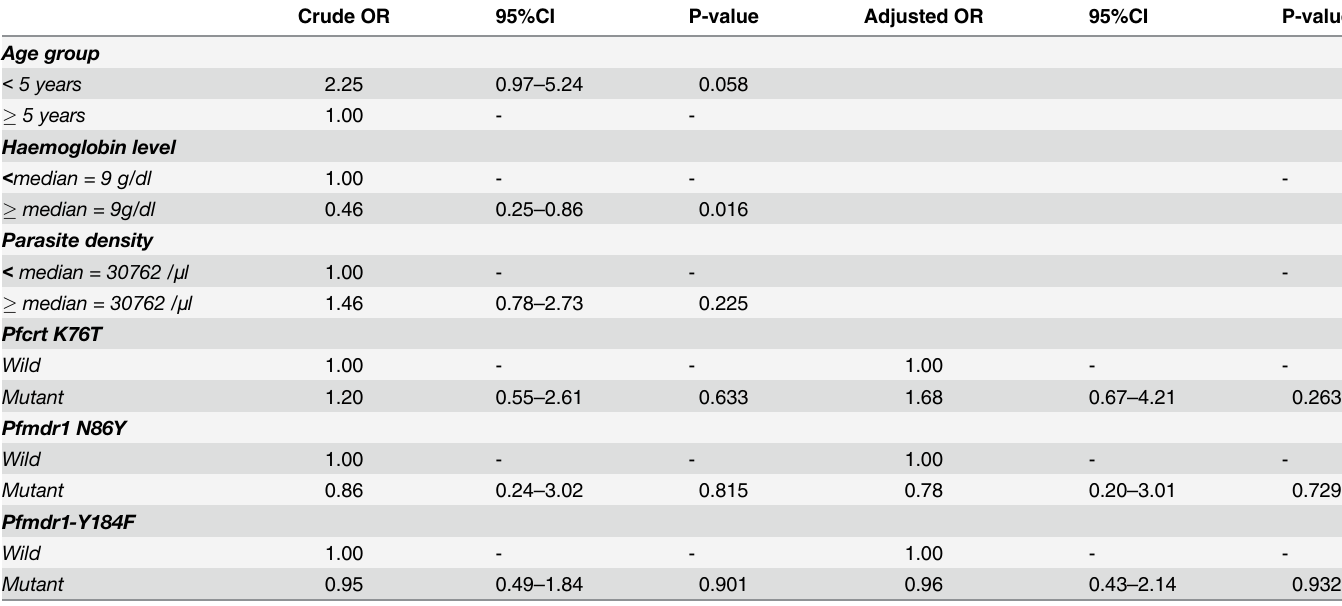
Table 4. Multivariate analysis of the association between SNPs in Pfcrt and Pfmdr1 genes and ASAQ treatment failure. Crude OR